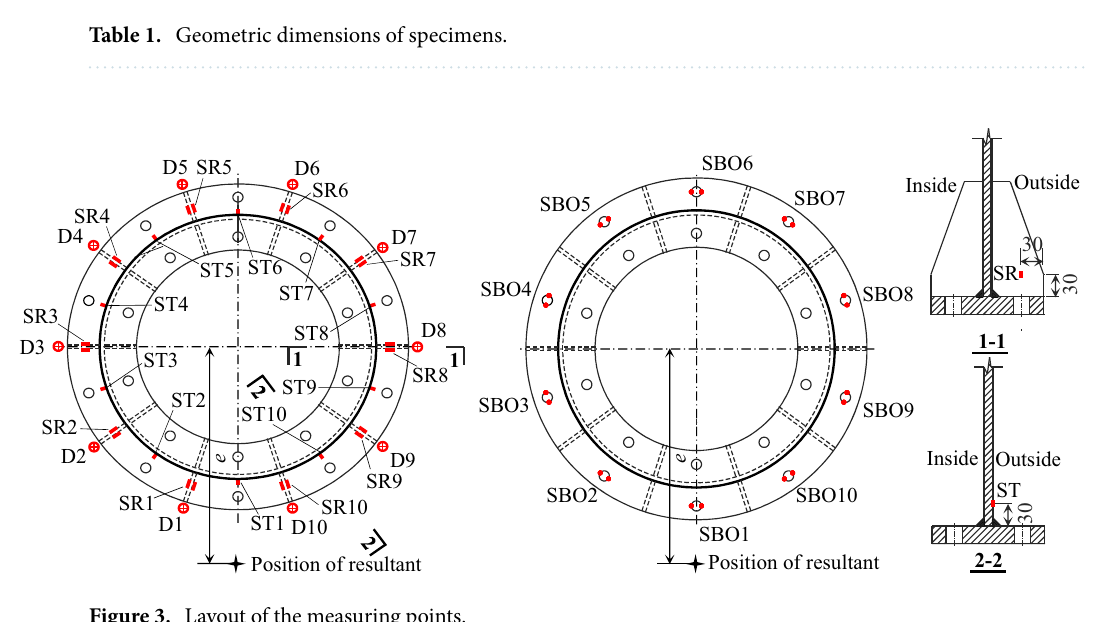
Figure 3. Layout of the measuring